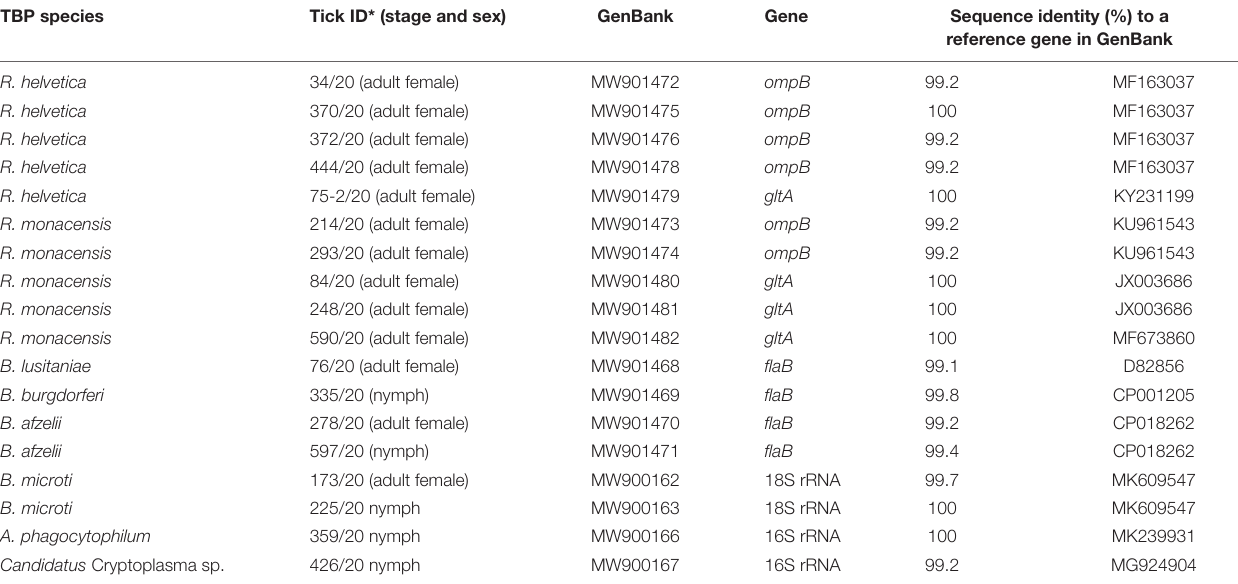
TABLE 4 | Sequence analysis of genes in selected